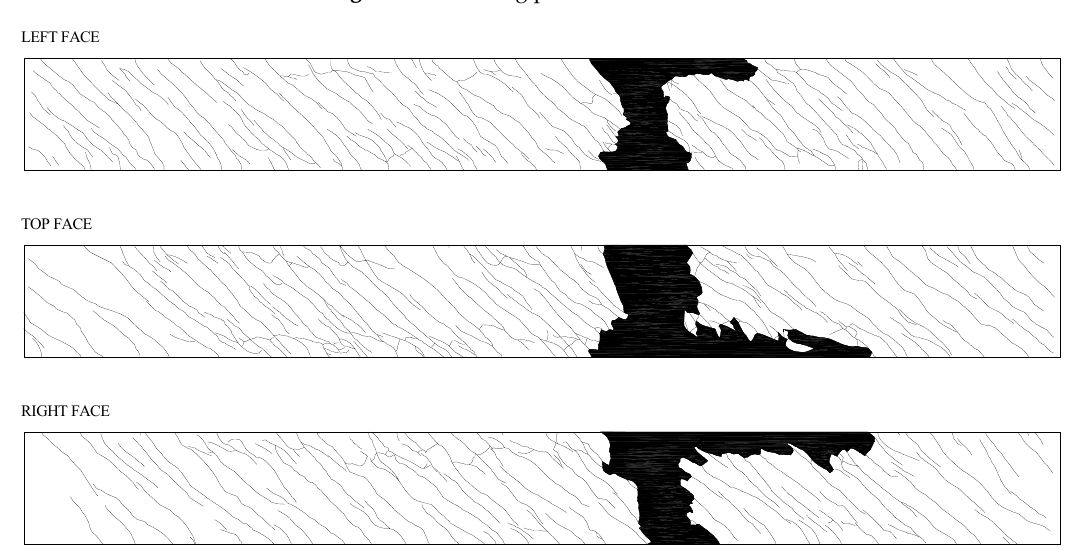
Figure 14. Cracking pattern: Beam D-3.08.